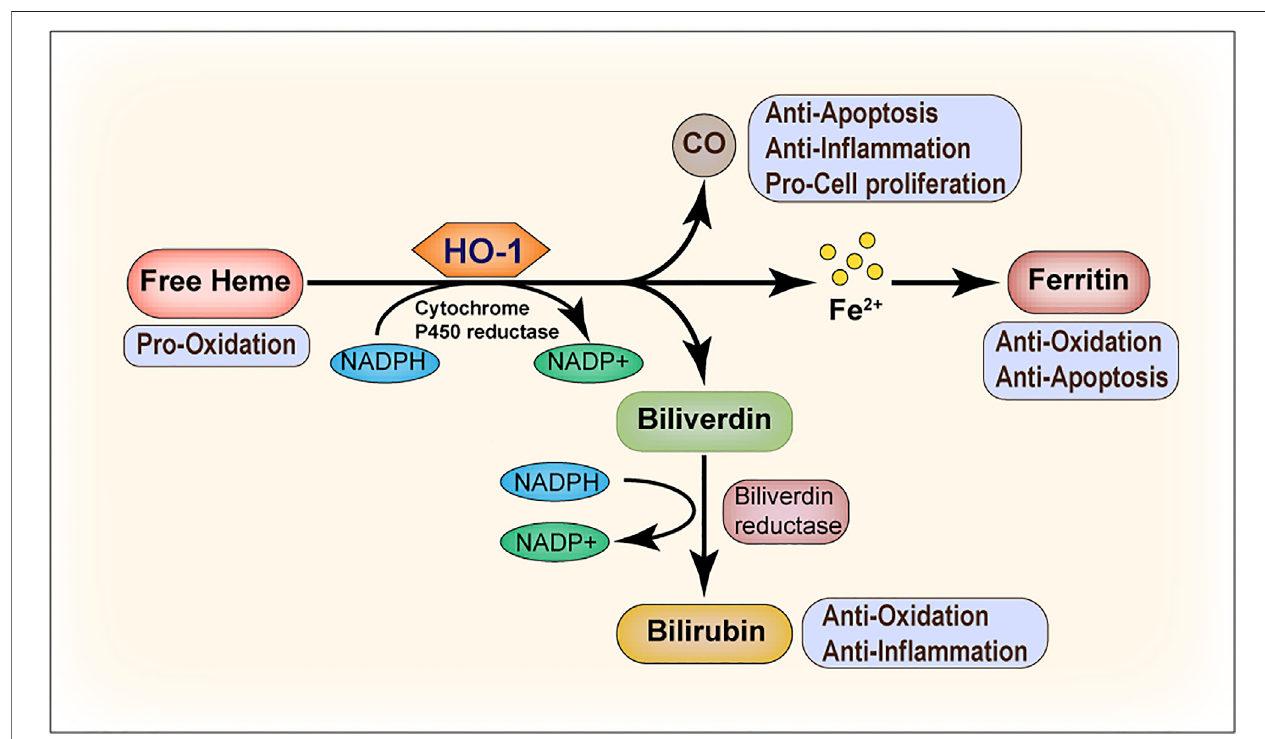
FIGURE 1 | Heme oxygenase-1 (HO-1) catalyzes heme degradation. Free heme is degraded by HO-1, leading to the production of biliverdin, carbon monoxide (CO),andferrousiron(Fe 2+ ).Biliverdinissubsequentlyconvertedtobilirubinbybiliverdinreductase,andFe 2+ issequesteredbyferritin.Thedegradationofhemeandthe conversion of biliverdin to bilirubin requires NADPH as the reducing agent. All the three end products, that is, biliverdin/bilirubin, CO, and Fe/ferritin, are cytoprotective. Under most conditions, biliverdin and bilirubin act as antioxidants. CO mainly inhibits the production of anti-in fl ammatory cytokines and upregulates the anti- apoptotic effectors. Ferritin serves as an antioxidant and suppresses cell apoptosis by binding and detoxifying ferrous iron.